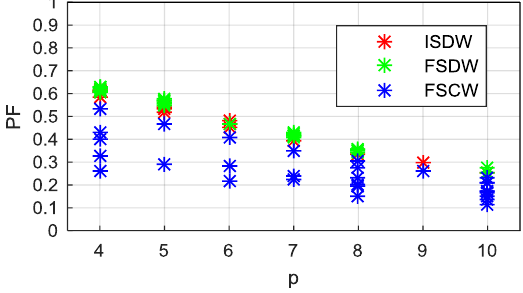
Figure 19. Power factor ( PF ) versus pole pair number ( p ) and winding type.